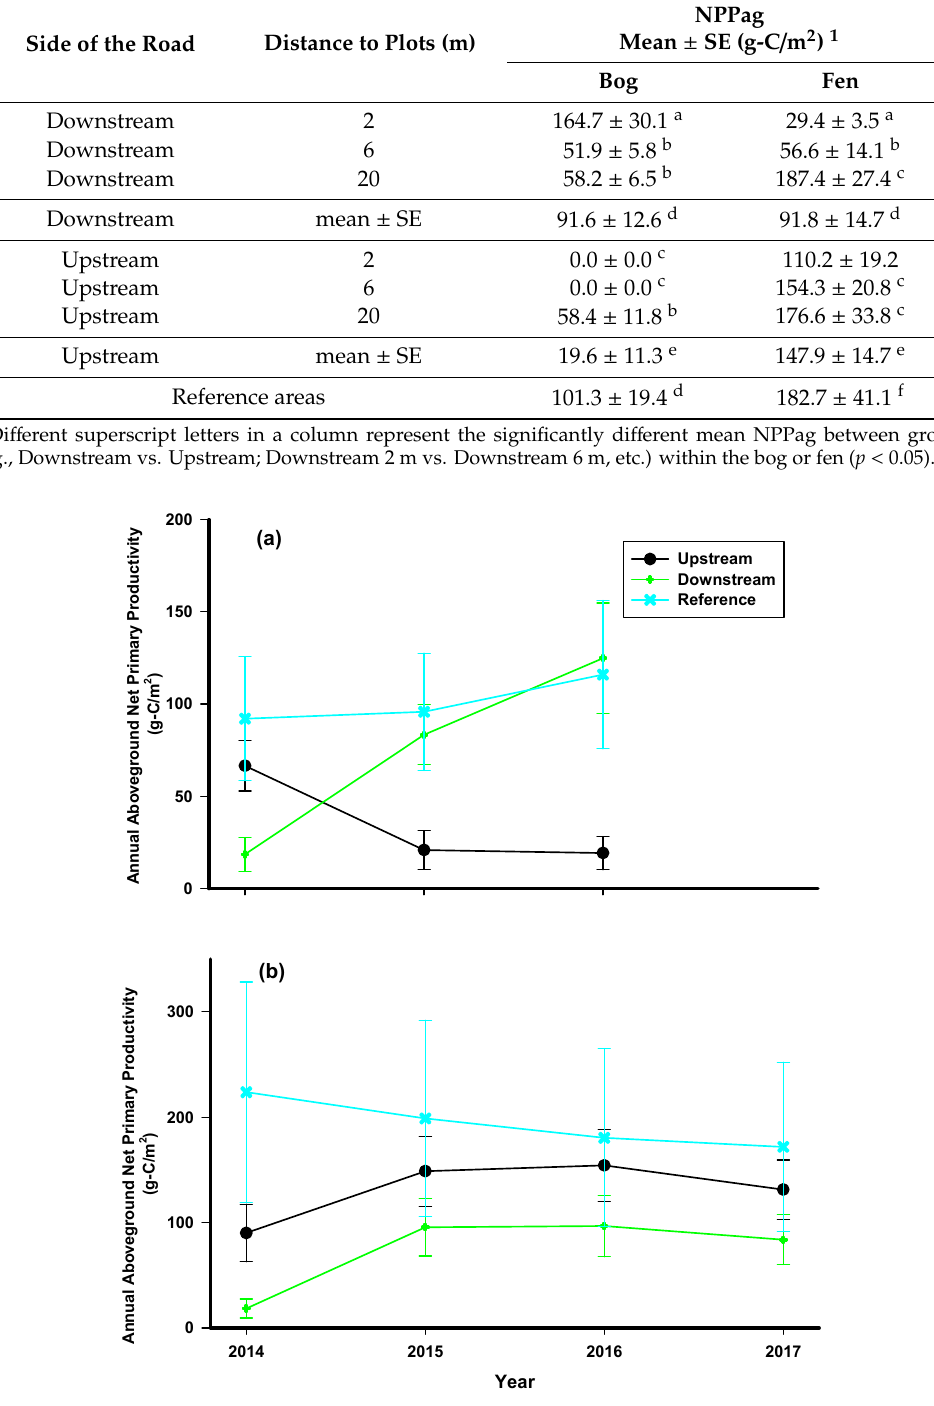
Figure 3. Annual aboveground tree and shrub net primary productivity (NPPag) in upstream and downstream areas of the road and reference areas at ( a ) bog and ( b ) fen sites during years post-road construction, Carmon Creek, Peace River, Alberta. Symbols and error bars represent the mean and standard errors of NPPag of the respective years.